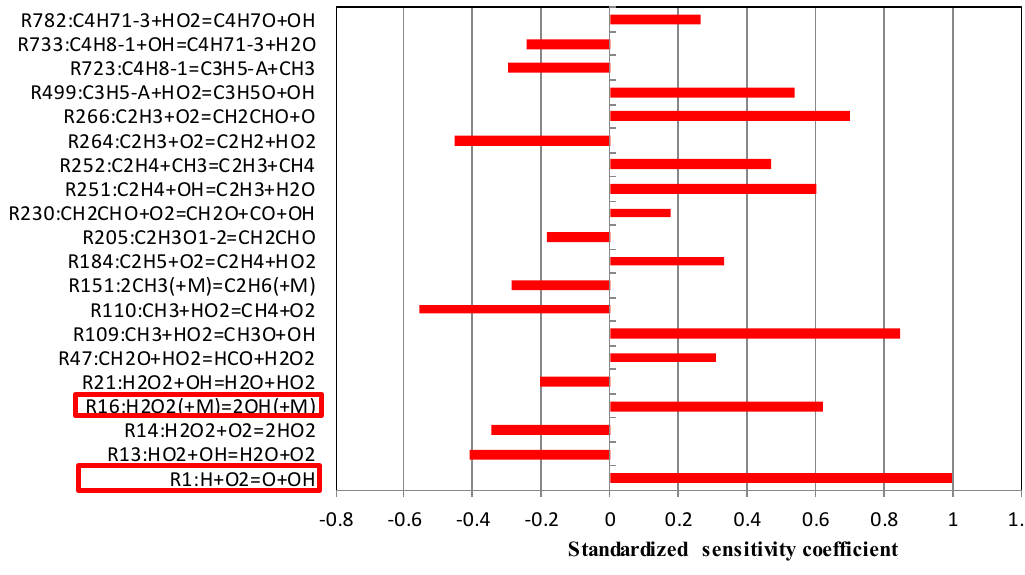
Figure 13. OH sensitivity analysis of N-heptane in the condition of 1250